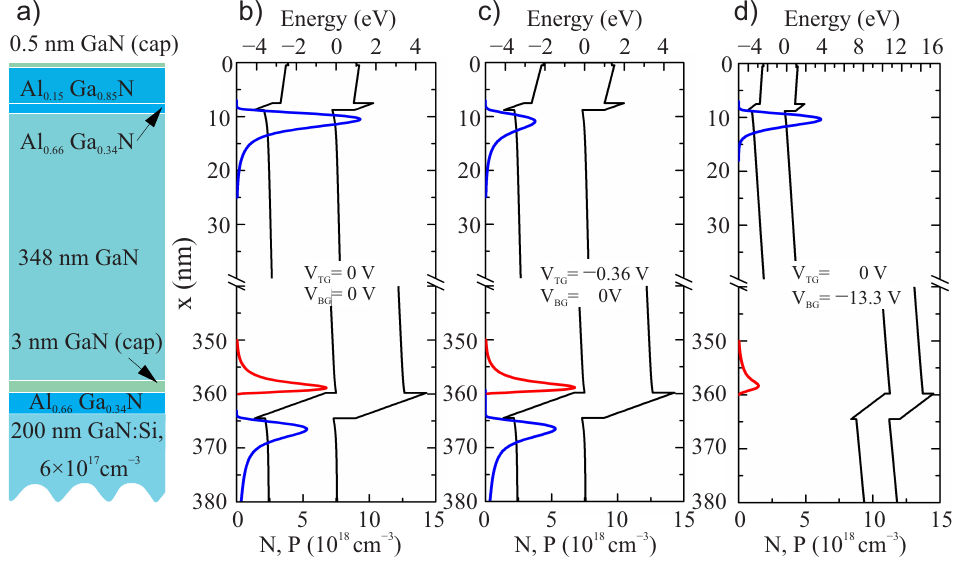
Figure 9. Layer sequence ( a ), band diagrams and carriers distributions at different configurations of the gate voltages ( b – d ). Gate voltages at ( c , d ) were adjusted to have approximately the same two-dimensional electron densities in the top conducting layer n s = 1.8 × 10 12 cm − 3